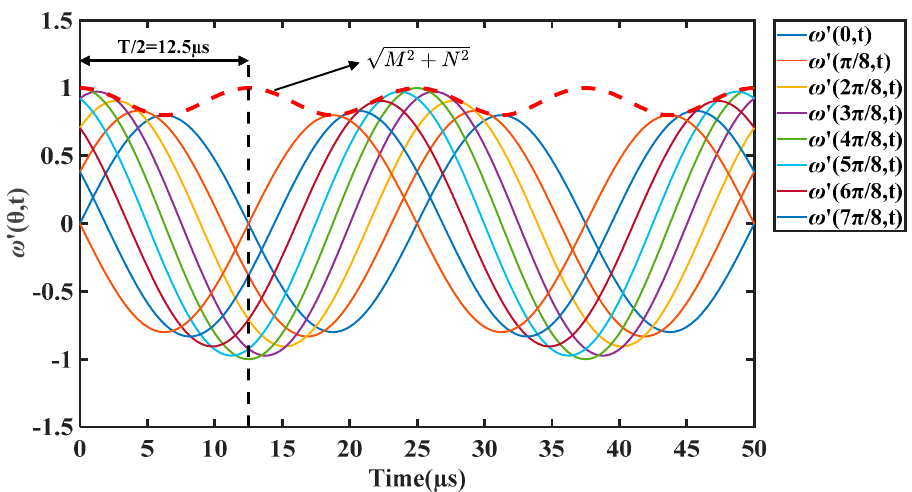
Figure 3. The vibration of surrounding particles on the ring stator.